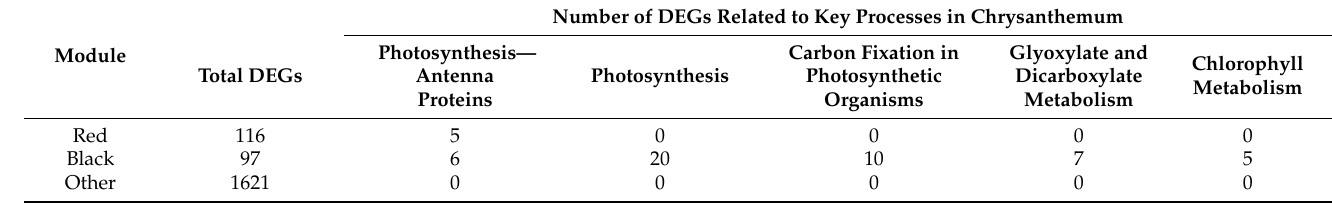
Table 3. Distribution of genes related to key pathways in 26